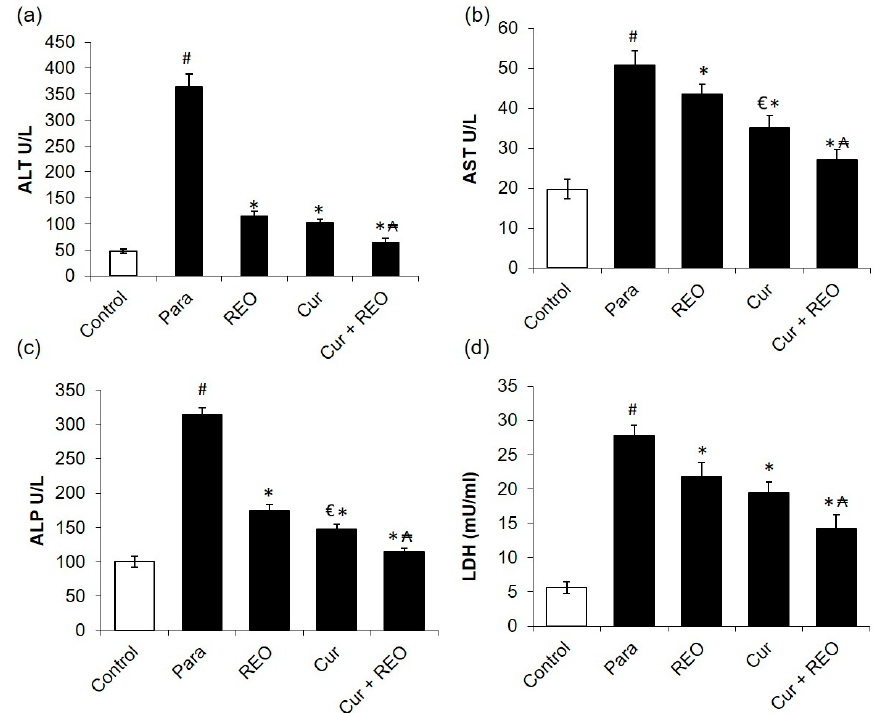
Figure 2. The effect of pretreatment with curcumin (Cur) and rosemary essential oil (REO) on serum ( a ) ALT, ( b ) AST, ( c ) ALP, and ( d ) LDH activities (U/L) in paracetamol (Para) induced liver toxicity